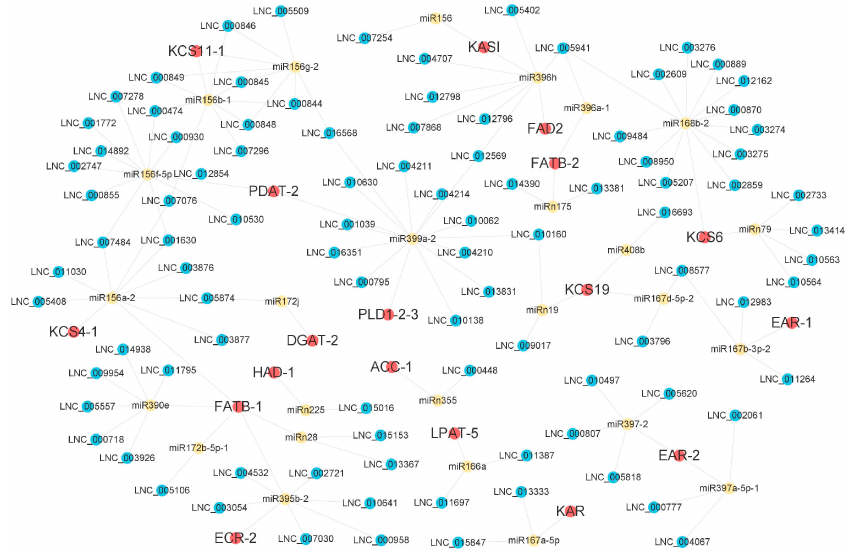
Figure 11. Network of DEL–DEM–DEG modules related to FA and TAG biosynthesis pathways. The DEGs, DEMs, and DELs are displayed as red, yellow, and blue circles, respectively.